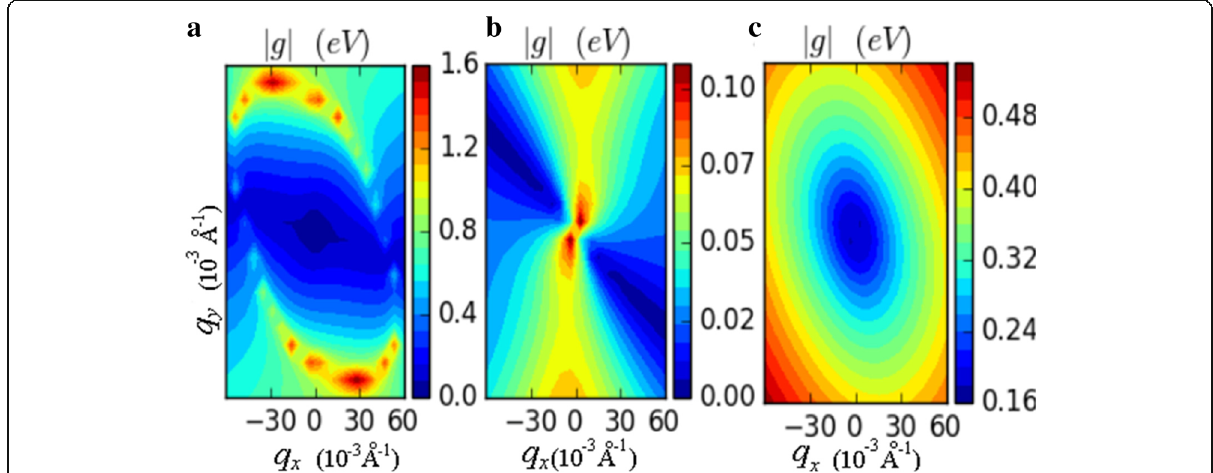
Fig. 5 The electron-phonon interaction matrix elements | g | of a LA, b TA, and c ZA